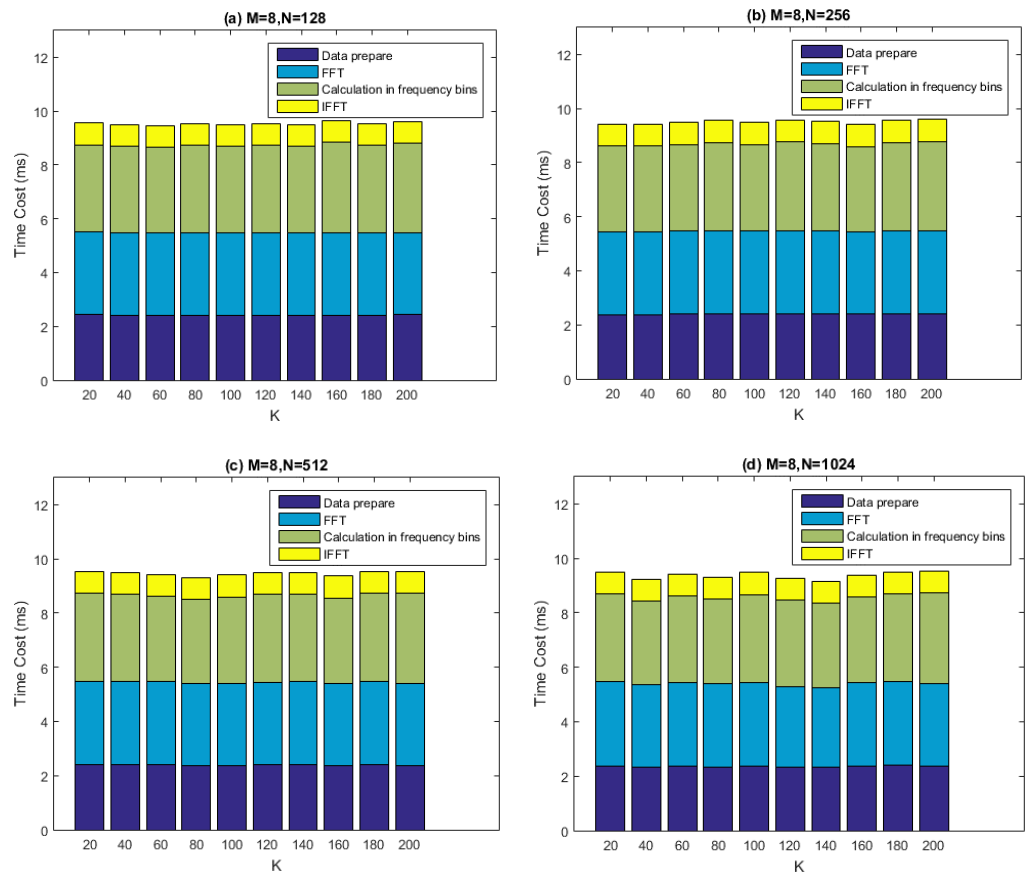
Figure 14. Performance of the batched SFAP implementation. M denotes the number of antenna elements and N denotes the FFT length. The real-time threshold is 50 ms. ( a ) Results of time cost when M is 8 and N is 128; ( b ) Results of time cost when M is 8 and N is 256; ( c ) Results of time cost when M is 8 and N is 512; ( d ) Results of time cost when M is 8 and N is 1024.